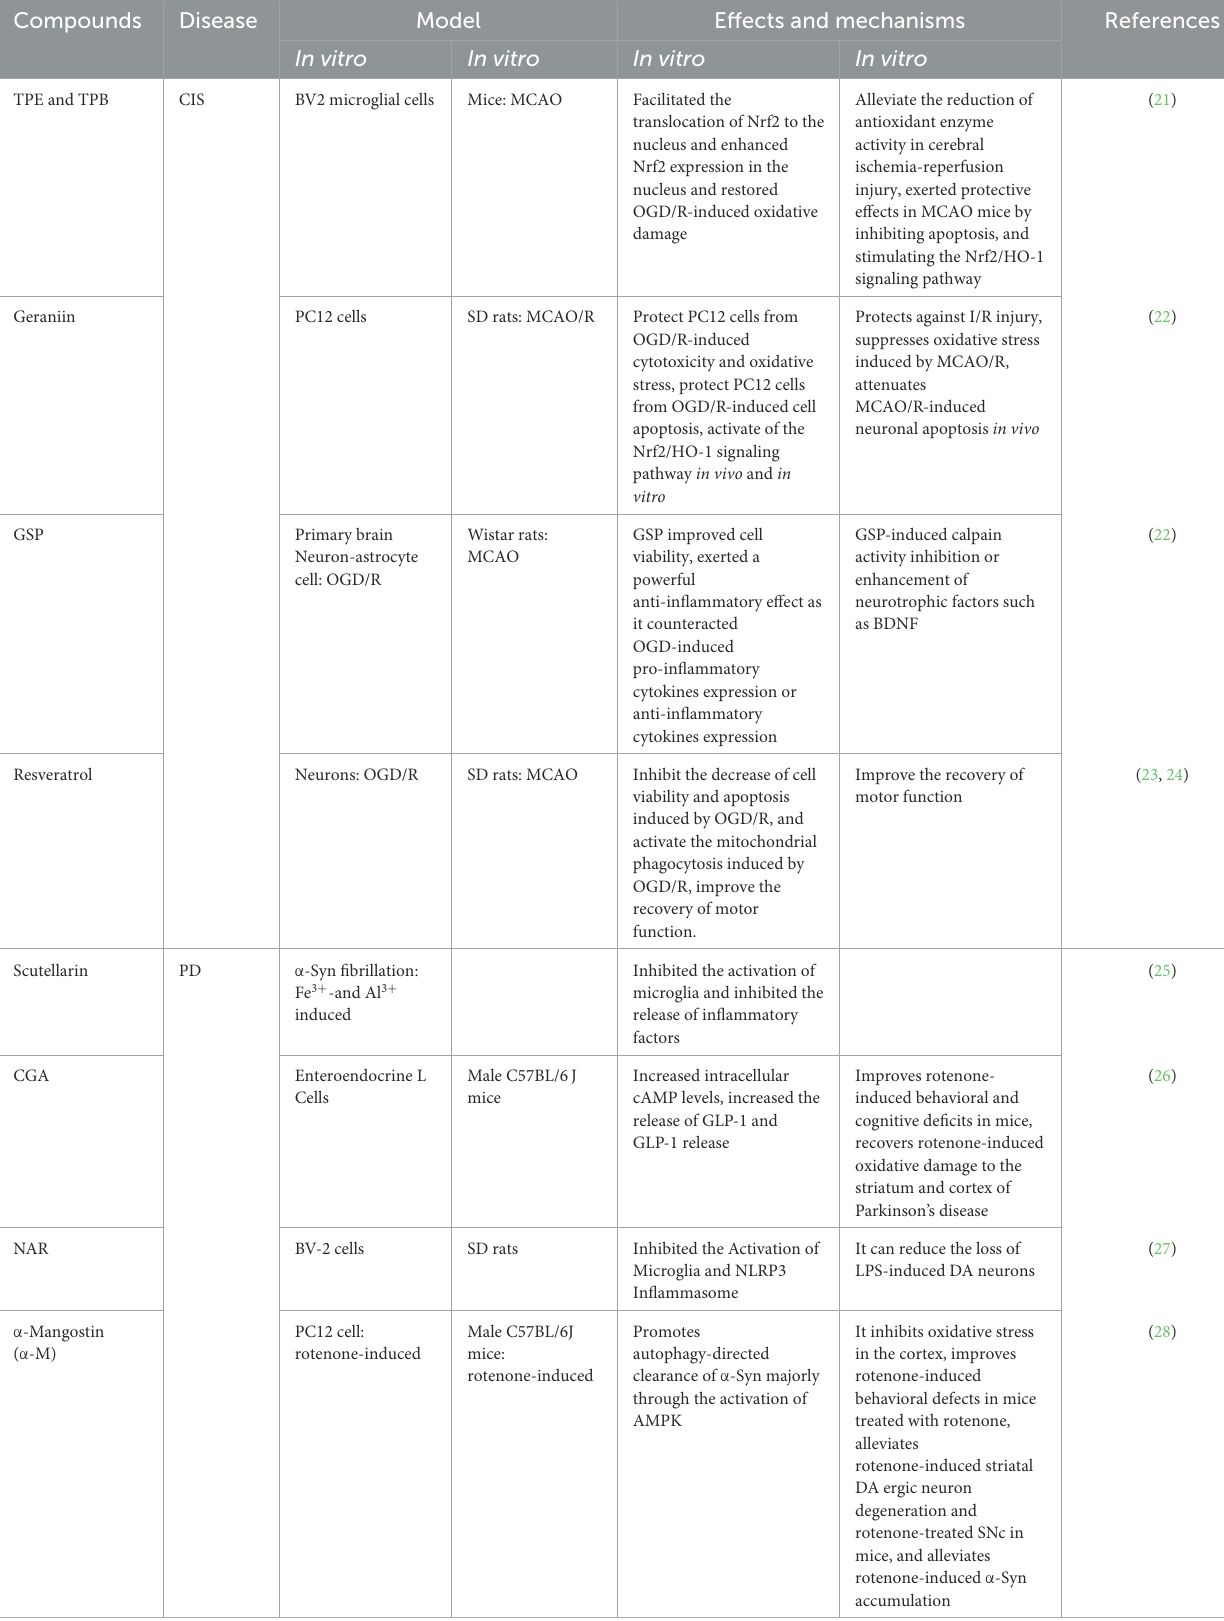
TABLE 1 Effects and mechanisms of polyphenols in the treatment of neurodegenerative diseases.